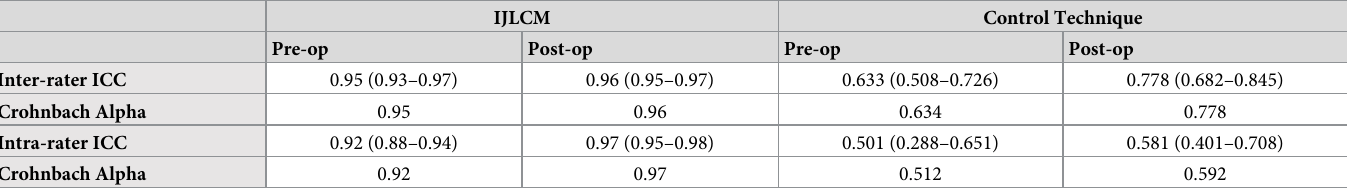
Table 3. ICC of measurements performed by senior orthopaedic surgeons.